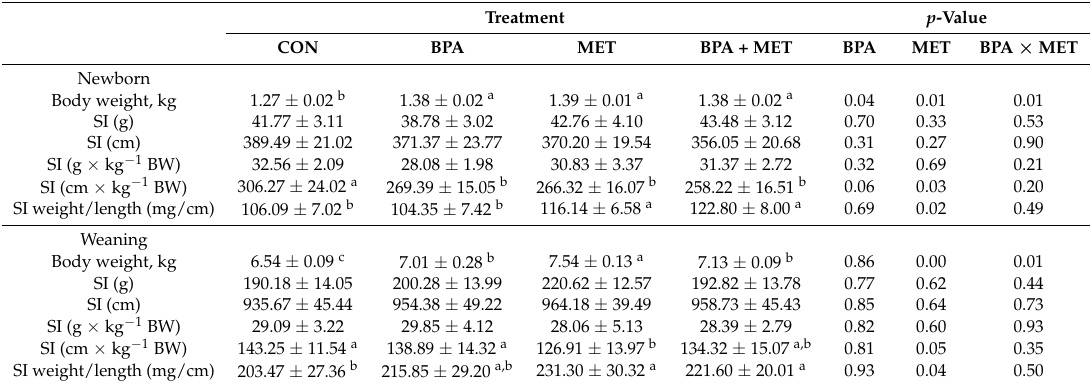
Table 4. Effect of maternal methyl donor or bisphenol A supplementation during gestation on intestinal index in newborn and weaning pigs.